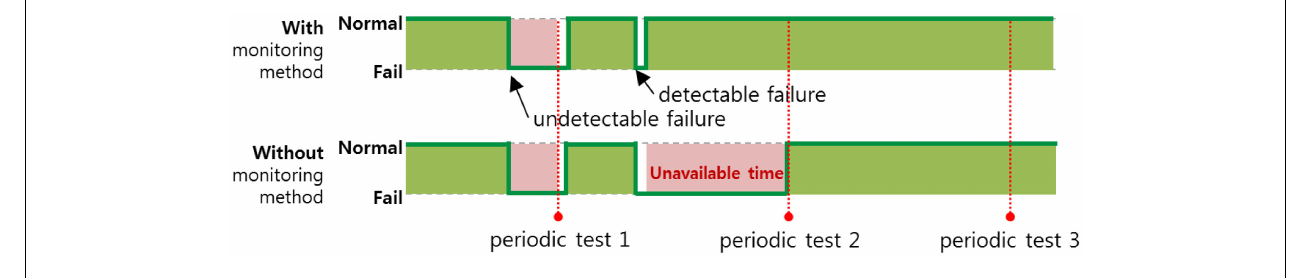
FIGURE 3 | Component unavailability reduction through monitoring